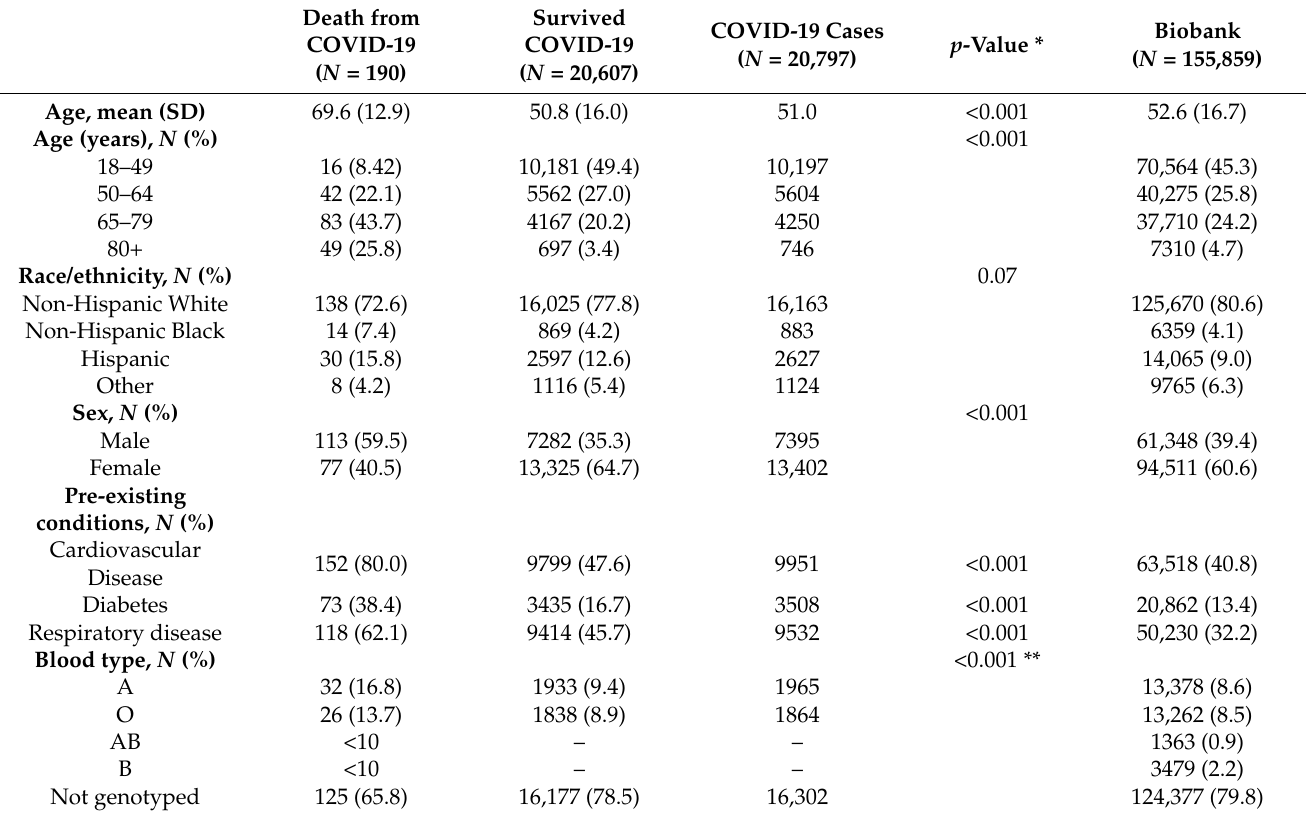
Table 1. Descriptive statistics. This table includes biobank participant characteristics.